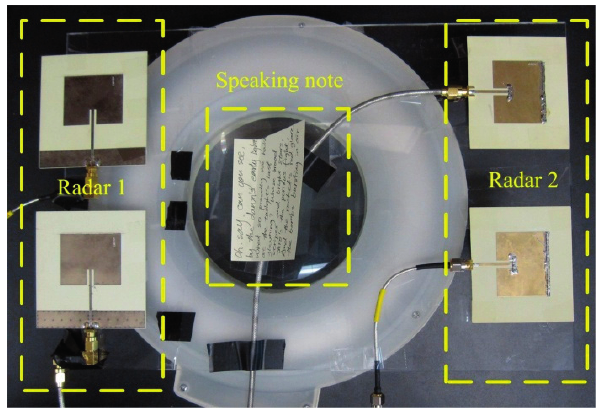
Figure 2. The antennas were placed in such a way that one radar used horizontally polarized antennas and the other radar used vertically polarized antennas. The speaking note was used to guide the subject during reading